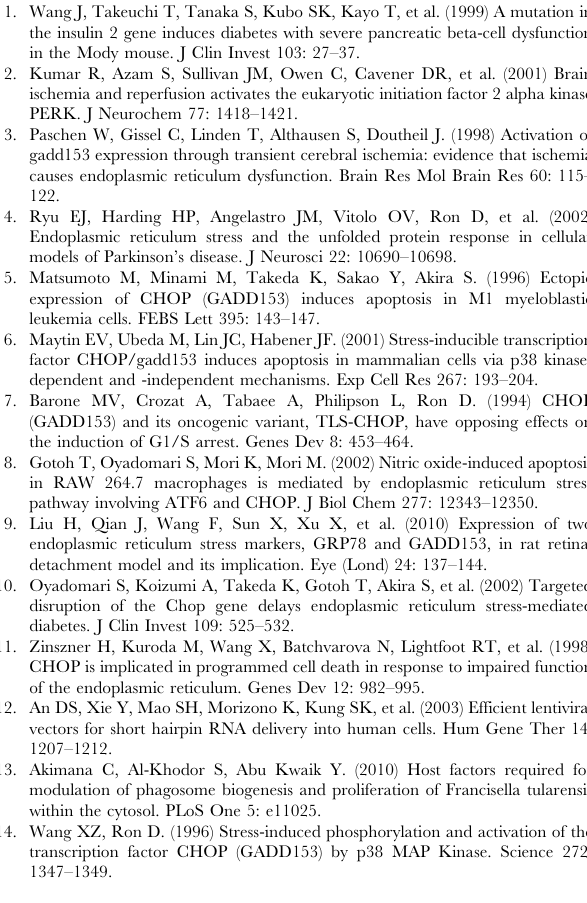
Figure S1 Delivery efficiency of lentivirus GADD153 shRNA-1 in vivo under stereo fluorescence microscope.